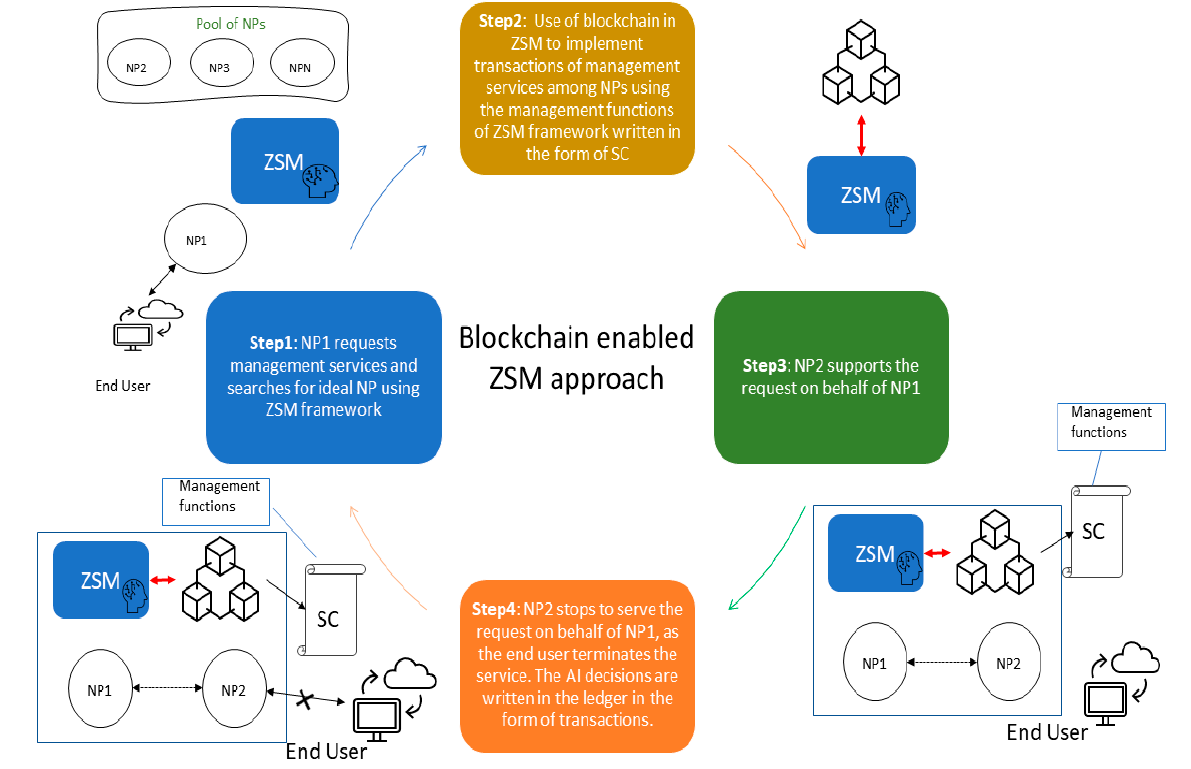
Figure 3. Lifecycle of a blockchain-enabled ZSM scenario.